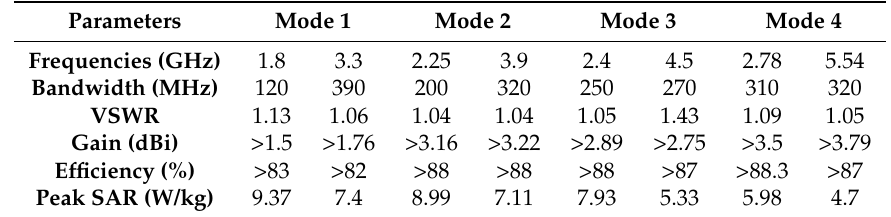
Table 3. Comparison of the proposed antenna with state-of-the-art reconfigurable antennas. Ref.